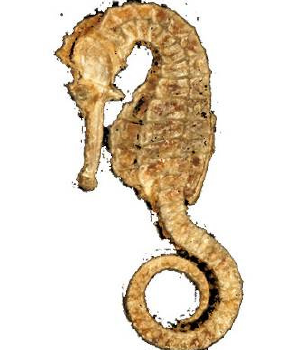
Figure 4. Seahorse textured DSM.